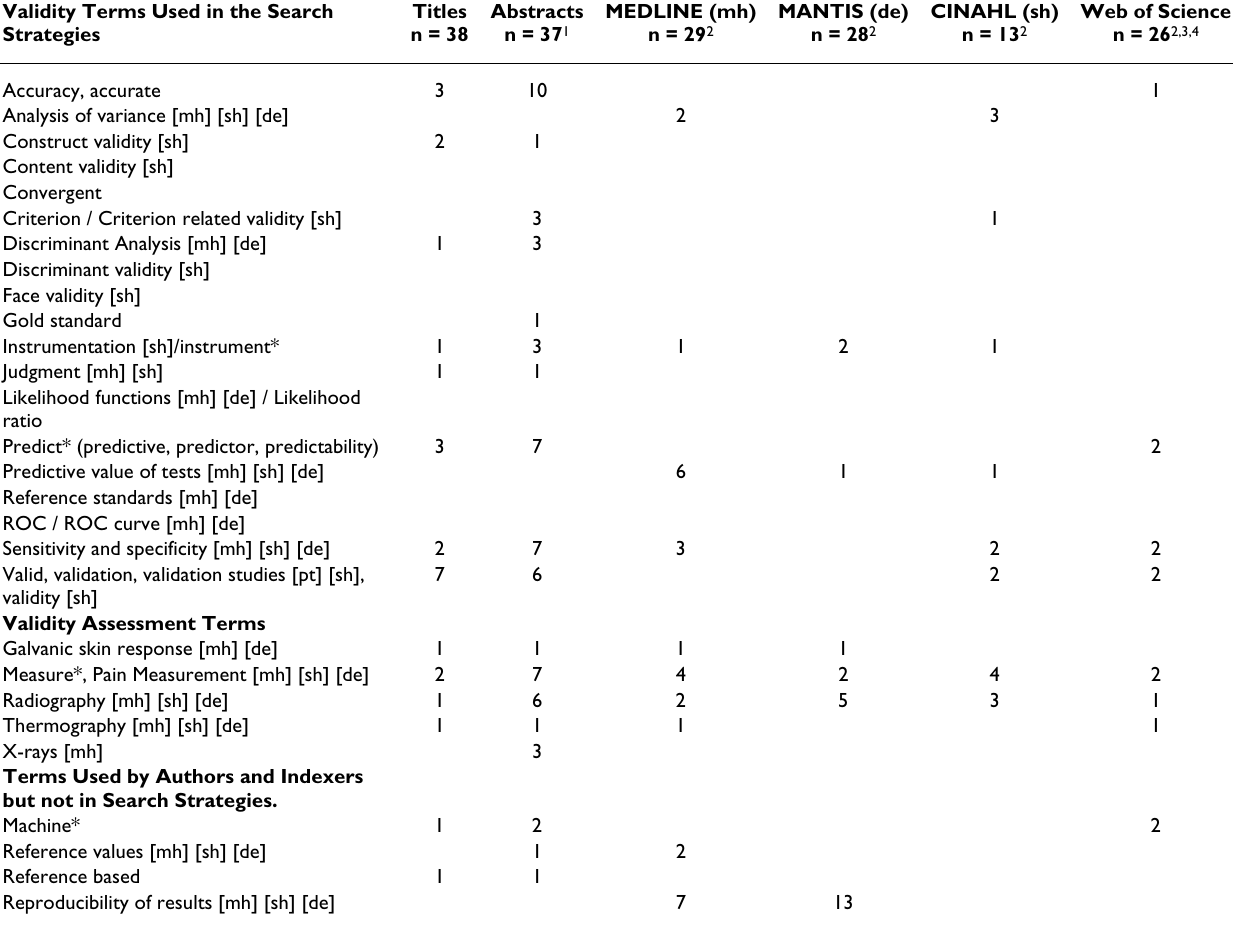
Table 2: Frequency of validity and validity assessment terms in titles, abstracts and four databases Validity Terms Used in the Search